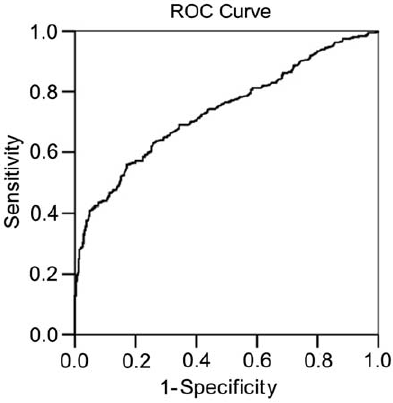
Figure 3. Receiver operating characteristic curves for APE1- AAbs level for NSCLC detection. Serum concentrations of APE1- AAbs levels among 292 NSCLC patients and 300 healthy controls were determined by ELISA. The diagnostic potentials of APE1-AAbs were assessed by ROC curves. The AUC value was 0.745.